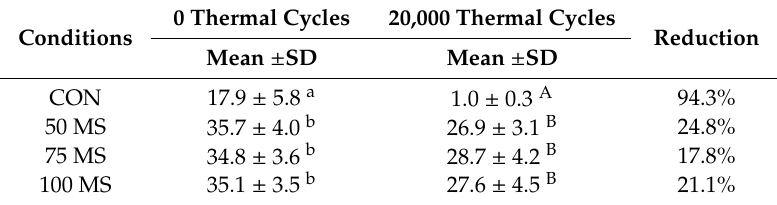
Table 2. Mean shear bond strengths (MPa) of acrylic resin bonded to